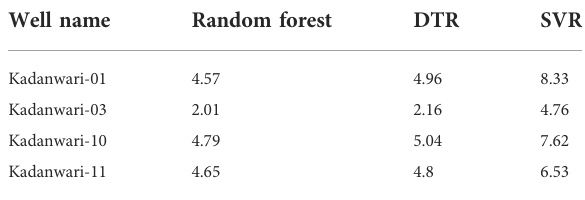
TABLE 6 Values of MAPE between predicted and measured DTS